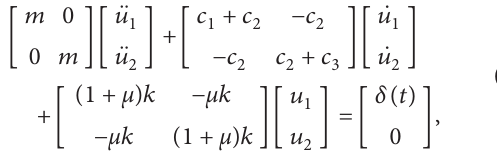
􏼈 􏼉 , in the case of three different values of k